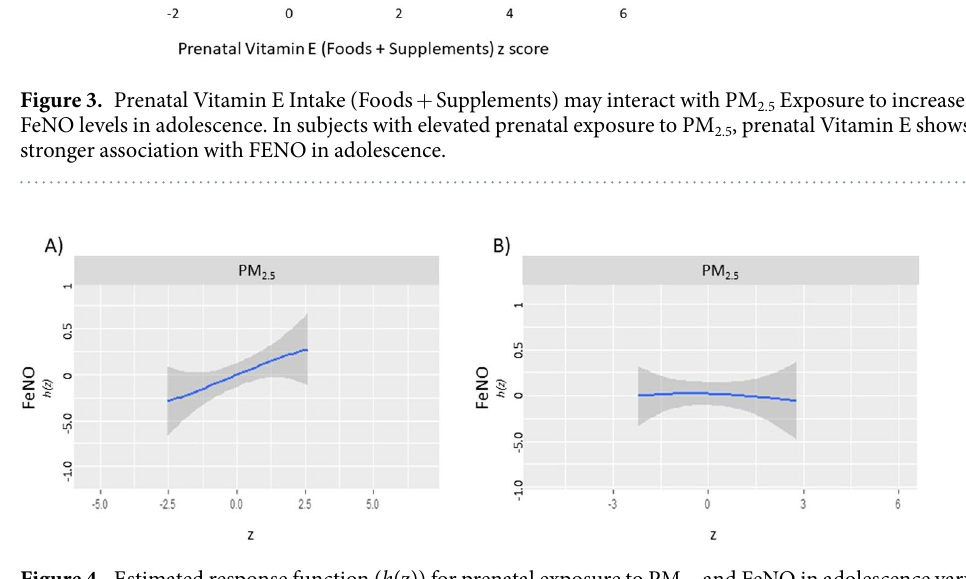
Figure 4. Estimated response function ( h (z)) for prenatal exposure to PM 2.5 and FeNO in adolescence vary by sex. Prenatal PM 2.5 exposure (z) was associated with increased FeNO in males ( A ), but not females ( B